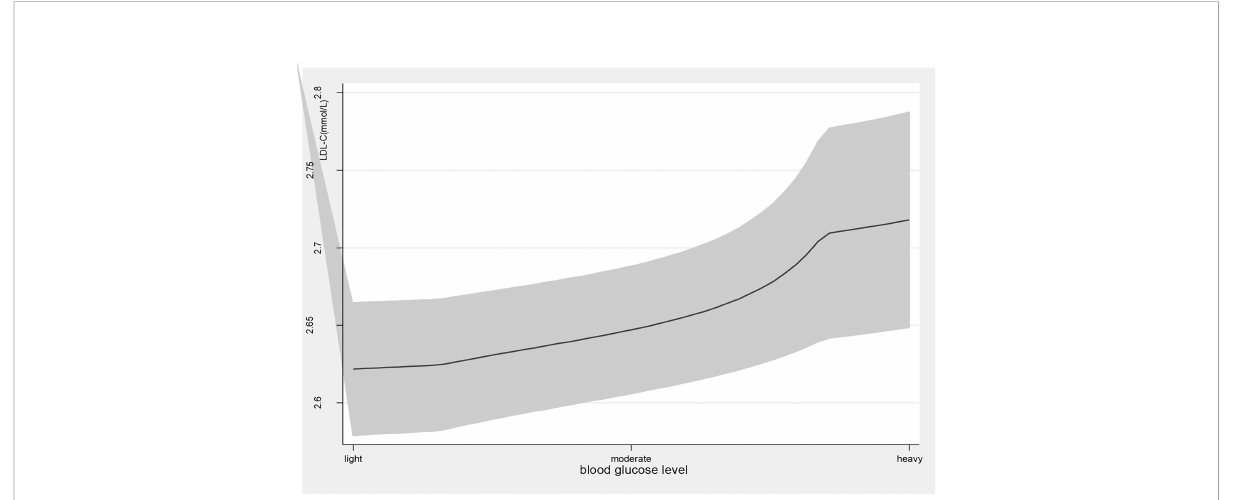
FIGURE 2 the level of LDL-C with the change of blood glucose level. with the high level of blood glucose, the LDL-C level was higher. line represent the value of LDL-C, the gray con fi dence intervals represent the 95% con fi dence intervals of